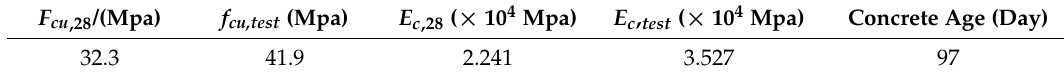
Table 3. Mechanical properties of concrete.